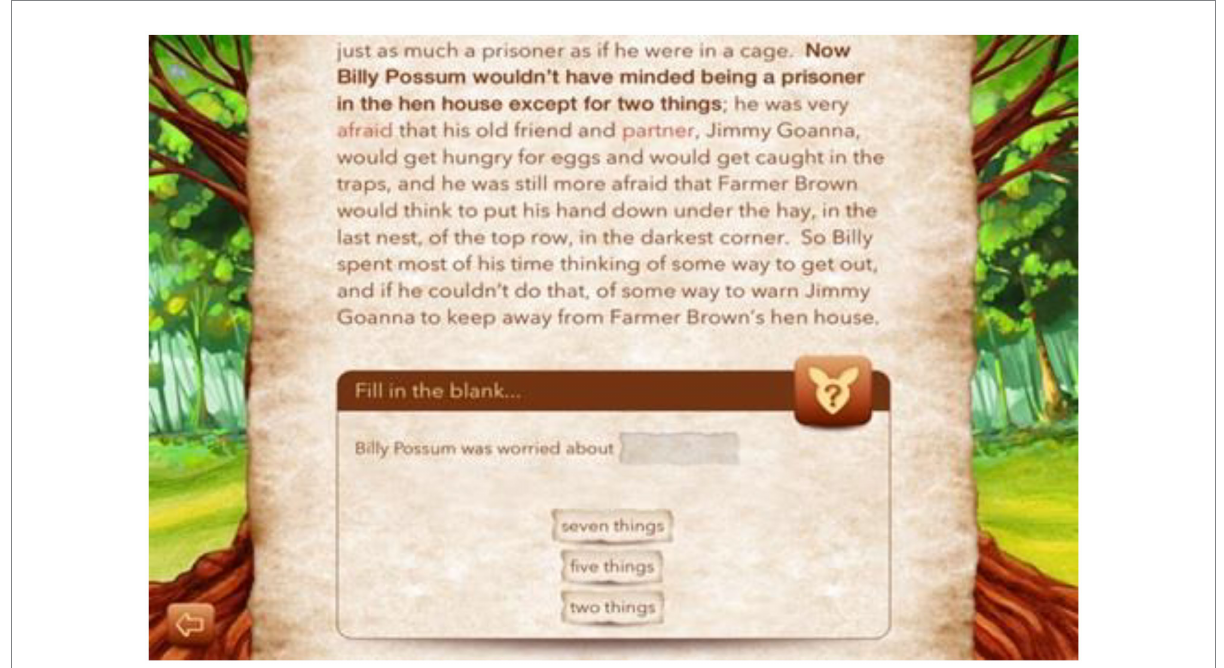
FIGURE 5 Screen shot in app after incorrect response and highlighted text to scaffold second response.